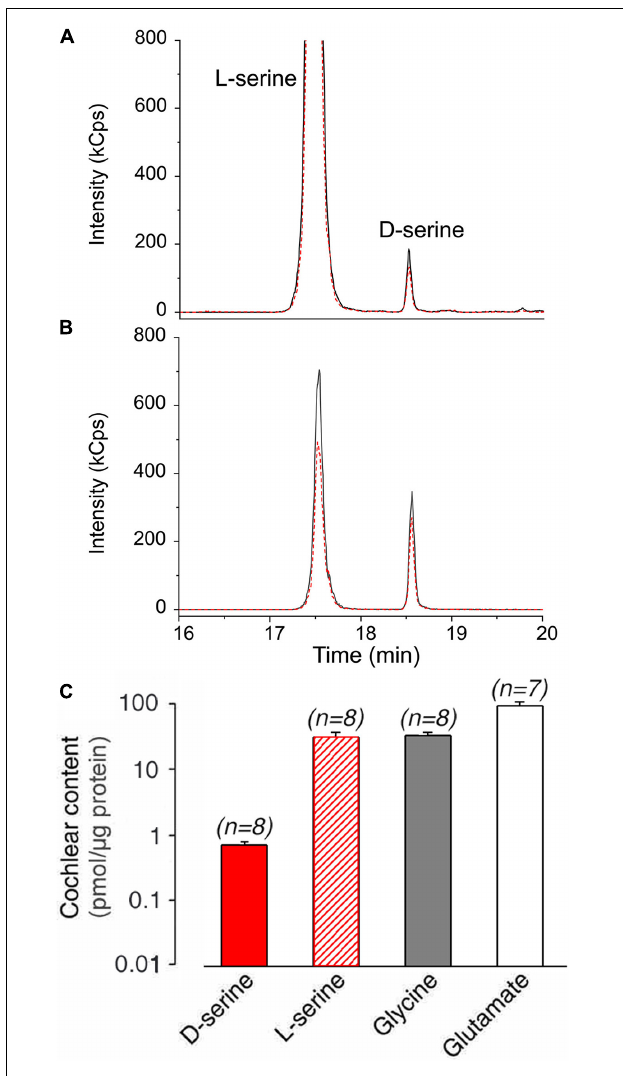
FIGURE 2 | D-serine content in adult mouse cochleae. (A,B) Liquid chromatography coupled to tandem mass spectrometry analysis of D-serine content in adult mouse cochlea. Representative LC-MS/MS chromatograms of L- and D-serine in mouse cochlea sample (A) and standard (B) acquired using LC-MS operating in multiple reaction monitoring (MRM) mode. Quantifier (384.3 → 162 m/z) and qualifier (384.3 → 321.7 m/z) transitions are denoted by solid black and dashed red lines, respectively. (C) Summary of quantification of D -serine, L -serine, glycine, and L -glutamate expressed in pmol/ µ g total cochlear protein. All values are expressed as means ± standard error (S.E), (n) number of cochlear